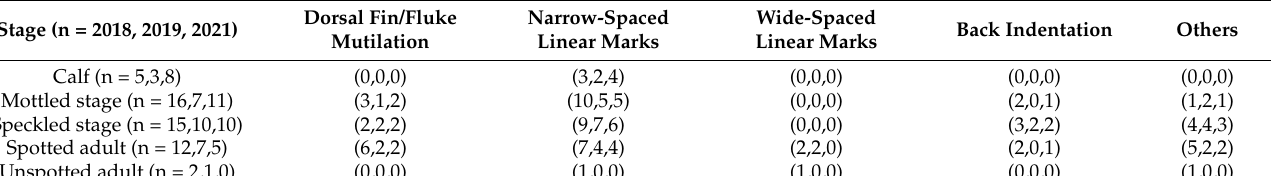
Table 3. Prevalence of injuries in 2018, 2019, and 2021.